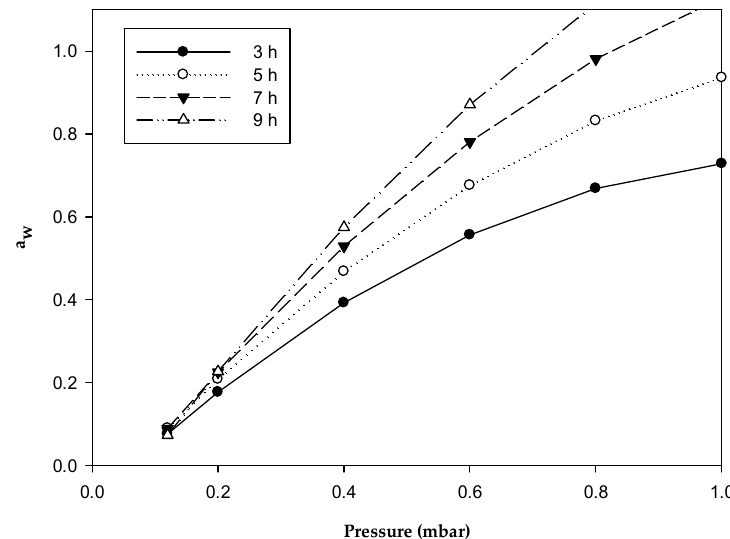
Figure 2. Predicted water activity of dried MKG at different freezing times and pressures. 193